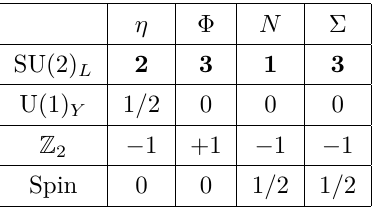
Table 2 . Contents of the new particle in the singlet-triplet fermion